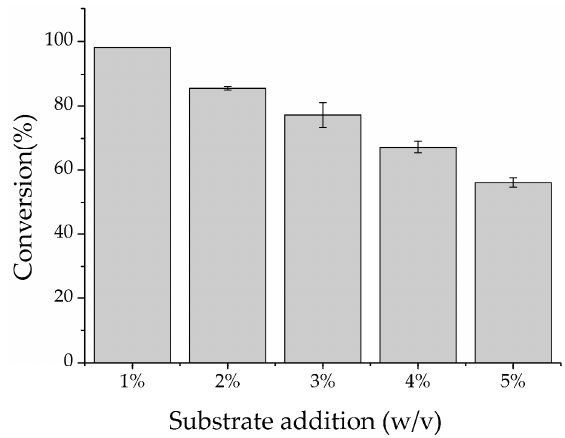
Figure 6. Optimization of substrate addition in terms of conversion of mannose with polyphosphate- dependent mannose kinase, and MgCl 2 (5 mM) at 30 °C at pH 8.5. As the amount of substrate increased, the conversion gradually decreased.